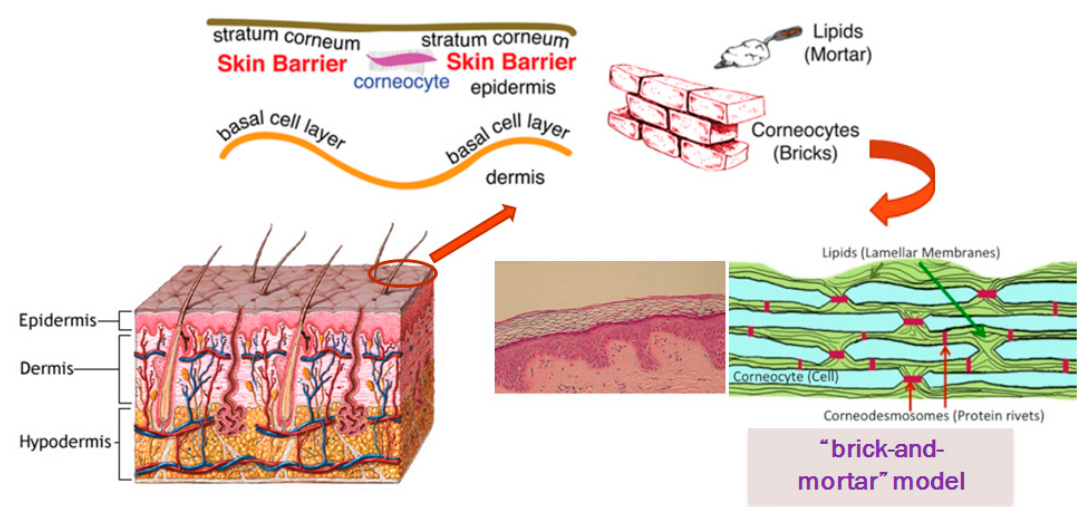
Figure 1. Structure of the stratum corneum.